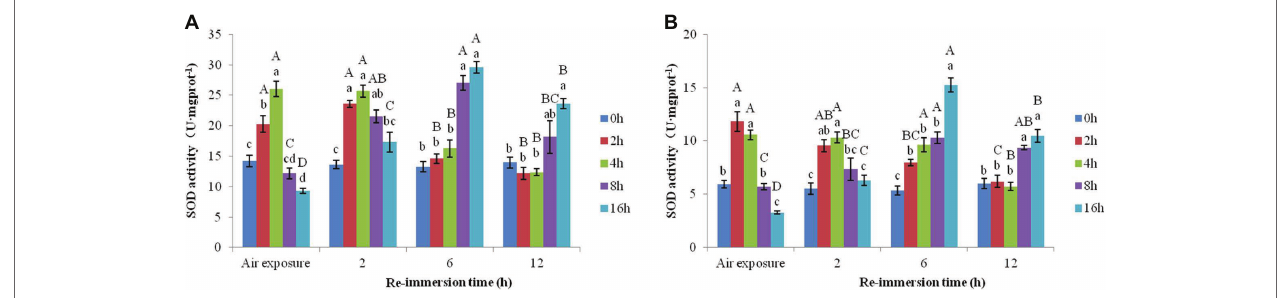
FIGURE 4 | Effects of air exposure and reimmersion on superoxide dismutase (SOD) in the gills (A) and hepatopancreas (B) of Chinese mitten crab. Different lowercase letters represent a significant difference between the different air exposure times at the same reimmersion time ( p < 0.05). Different uppercase letters represent a significant difference between the different reimmersion times at the same air exposure time ( p <